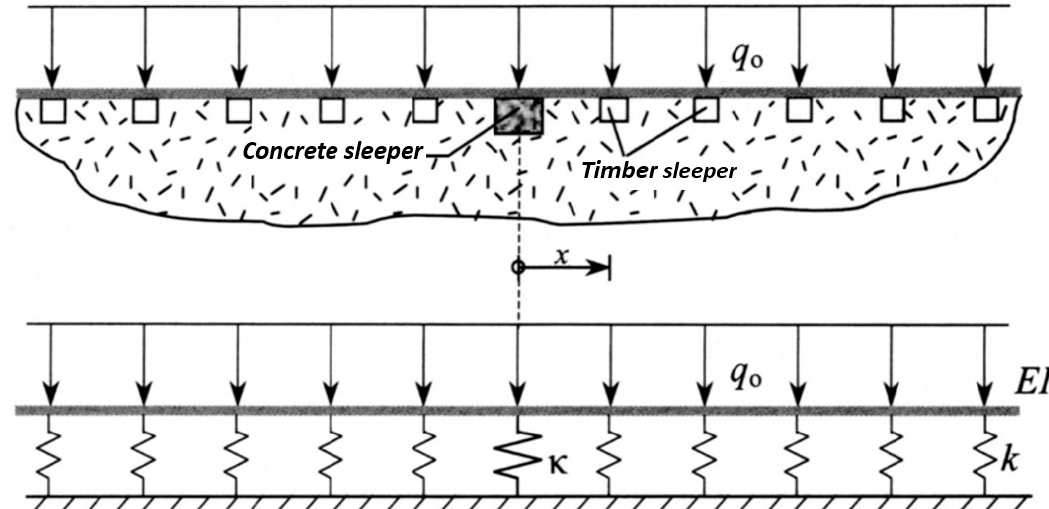
Figure 3. The analytical model of the interspersed concrete sleeper in a continuous welded rail track [29].